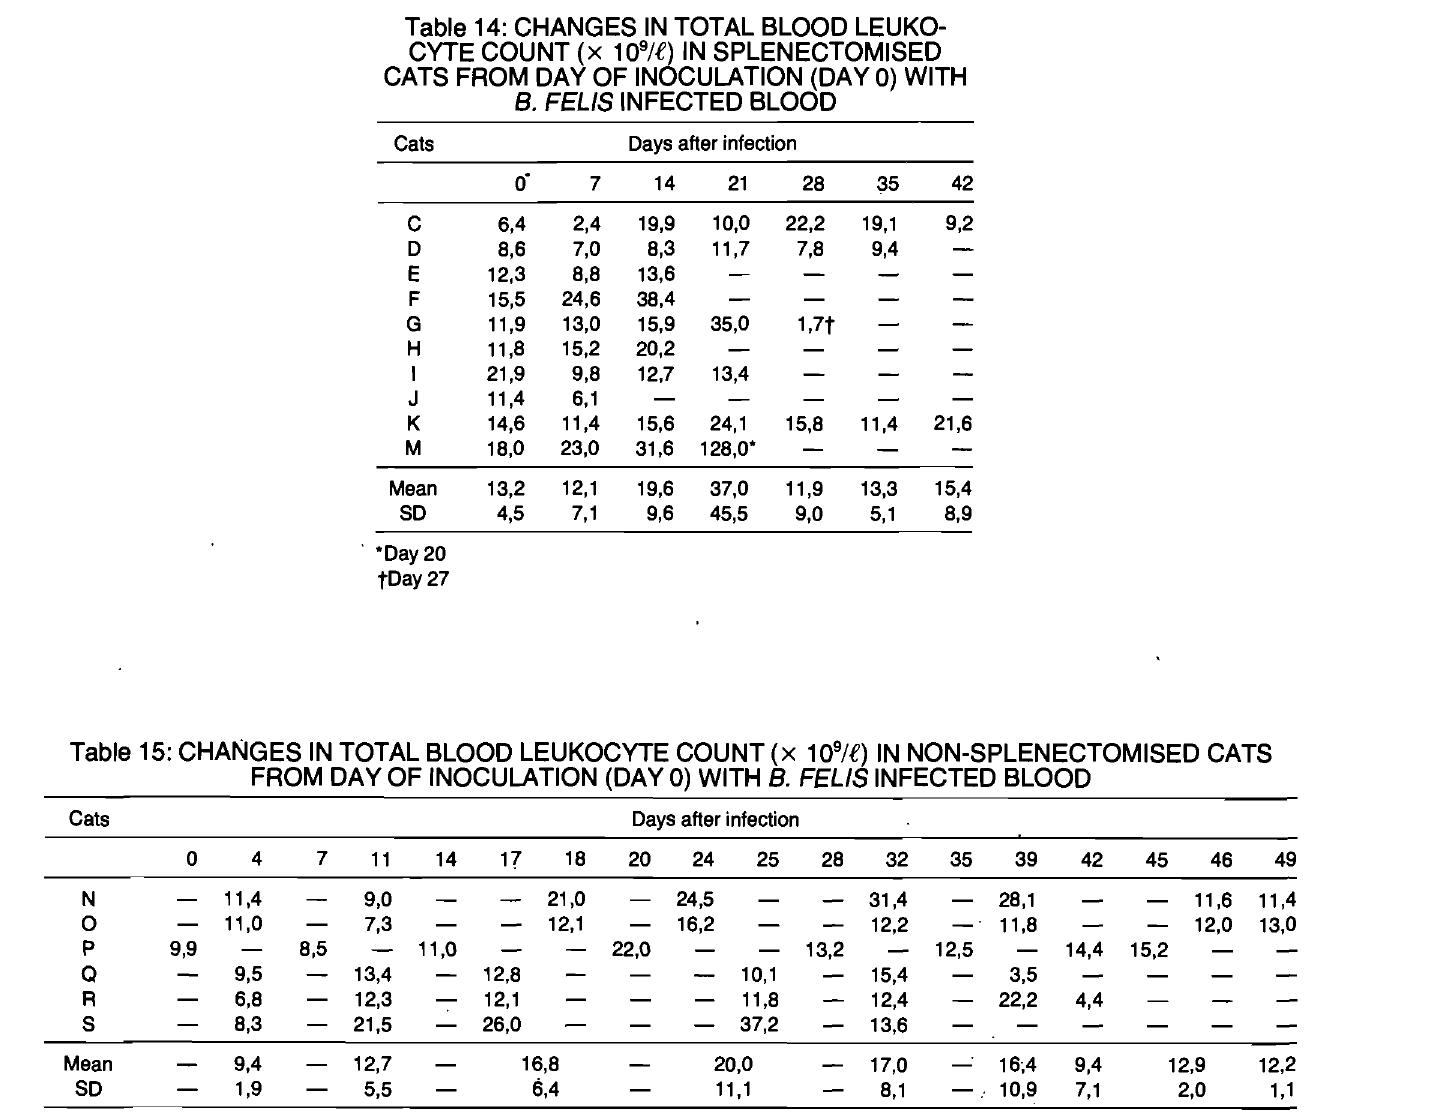
Table 14: CHANGES IN TOTAL BLOOD LEUKO-